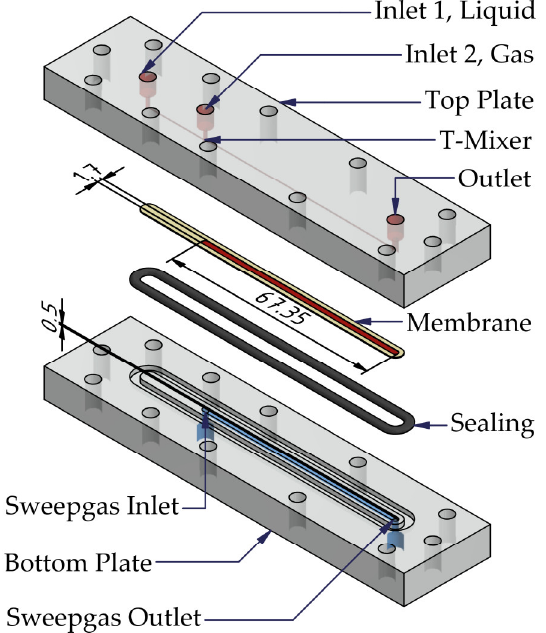
Figure 5. Exploded-view of the membrane based micro contactor with integrated T-junction for two-phase flow generation.